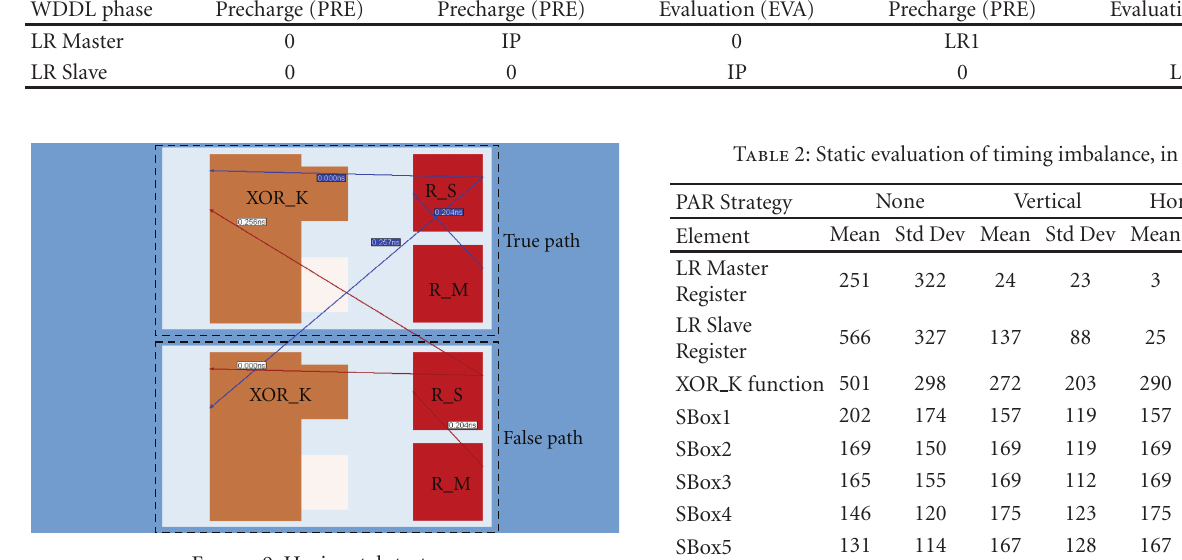
Figure 9: Horizontal strategy.